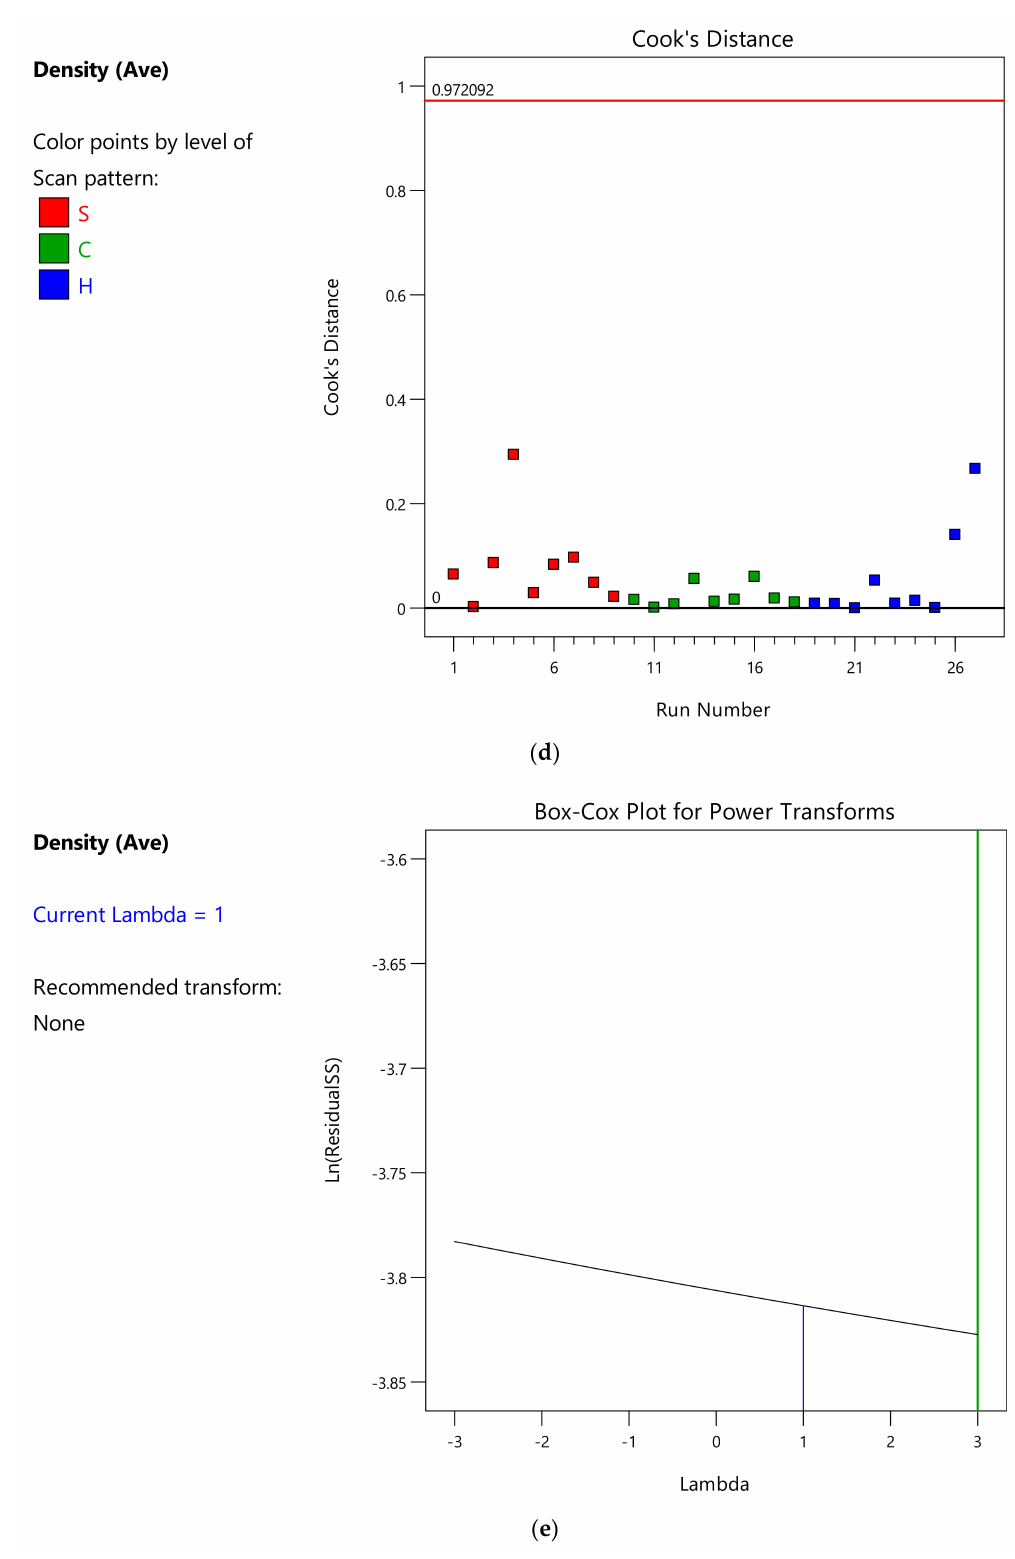
Figure A3. Statistical quality assertion: ( a ) Half-Normal plot vs. Externally studentized residuals for random error check, ( b ) Residuals vs. predicted value for independent residuals, ( c ) Residual vs. run for the absence of variation from printing location, ( d ) Cook’s distance plot for identification of outliers and ( e ) Box-Cox plot to identify any need of a transformation of the